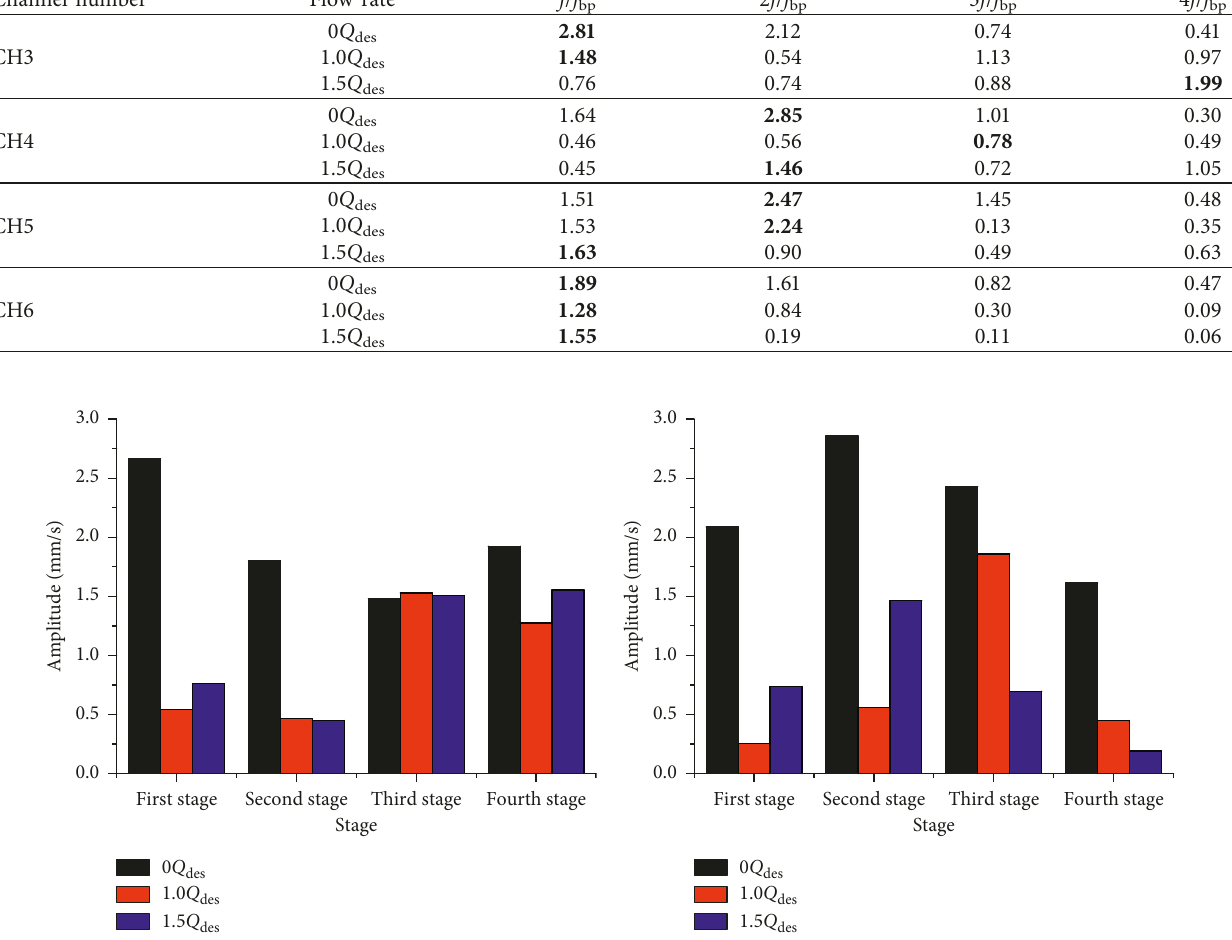
Table 2: Peak value and relative harmonics of each monitoring point under varied conditions. Channel number